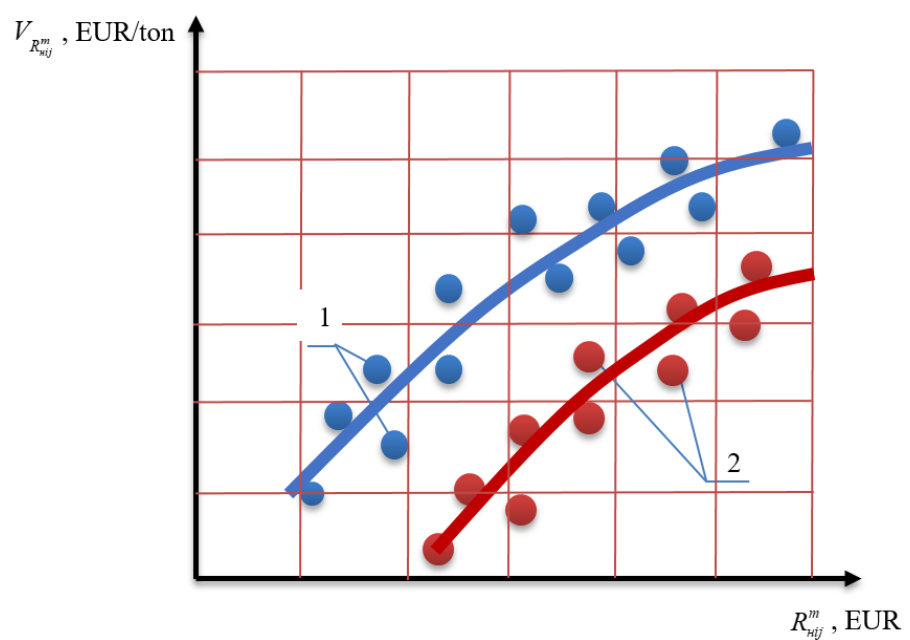
Figure 2. Value model of technologically integrated “ European Green Deal ” projects that claim to be included in effective technologically integrated projects: R m т of the t -th level of their consideration (1 – projects of agricultural waste procurement; 2 – projects of environmentally friendly energy production).